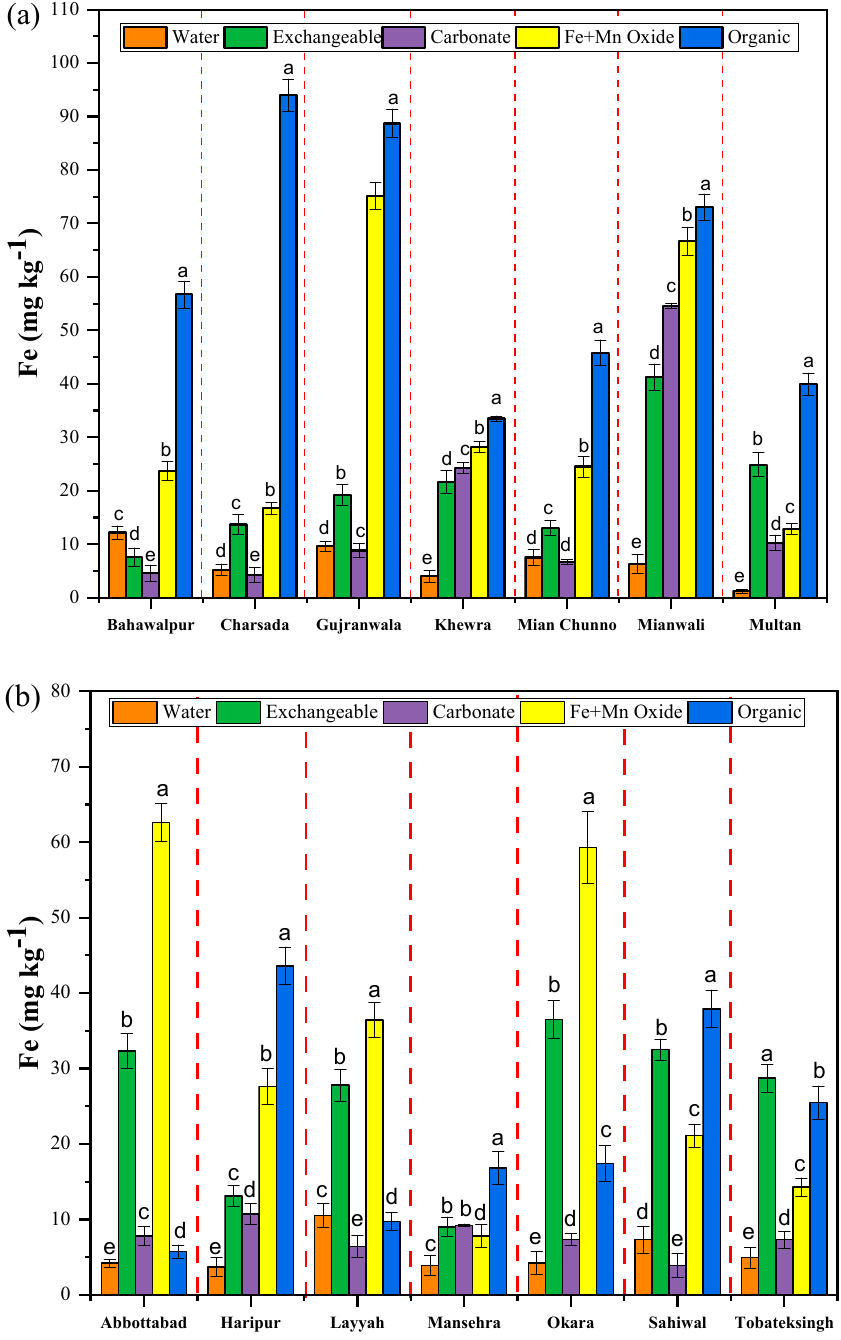
Figure 2. Fractionation of Fe in saline ( a ) and non-saline soils ( b ). 1) LSD test was used to determine significance difference between the different fractions of Cu. Alphabets indicate the statistical difference among metal fractions. 2) The red lines separate the regional areas of agriculture.